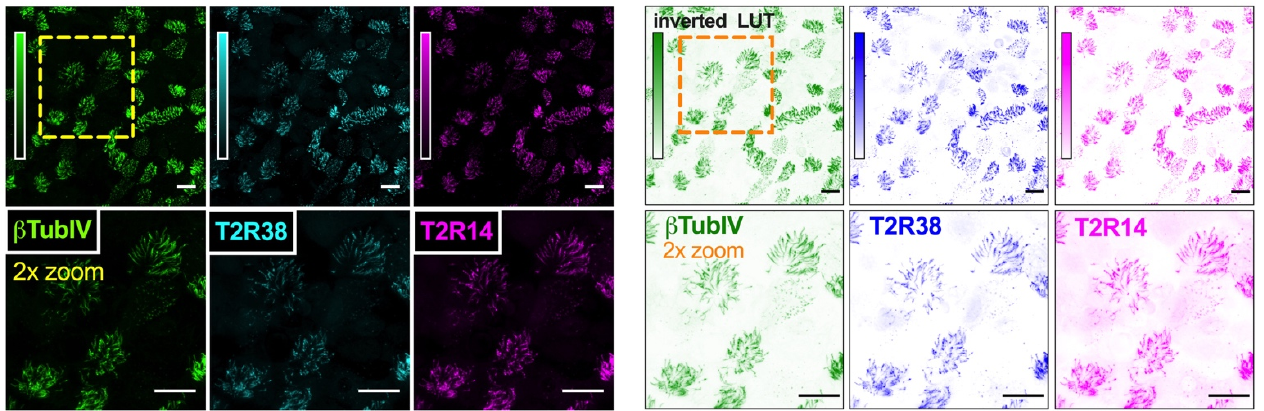
Figure 3. T2R bitter taste receptor expression in airway cell cilia. Representative images of cilia marker β -tubulin IV (green), T2R38 (cyan) and T2R14 (magenta) immunofluorescence in an apical confocal section of primary human sinonasal ALI. ( Left ) shows conventional look-up table (LUT) and ( right ) shows inverted LUT. Scale bar is 20 µm.